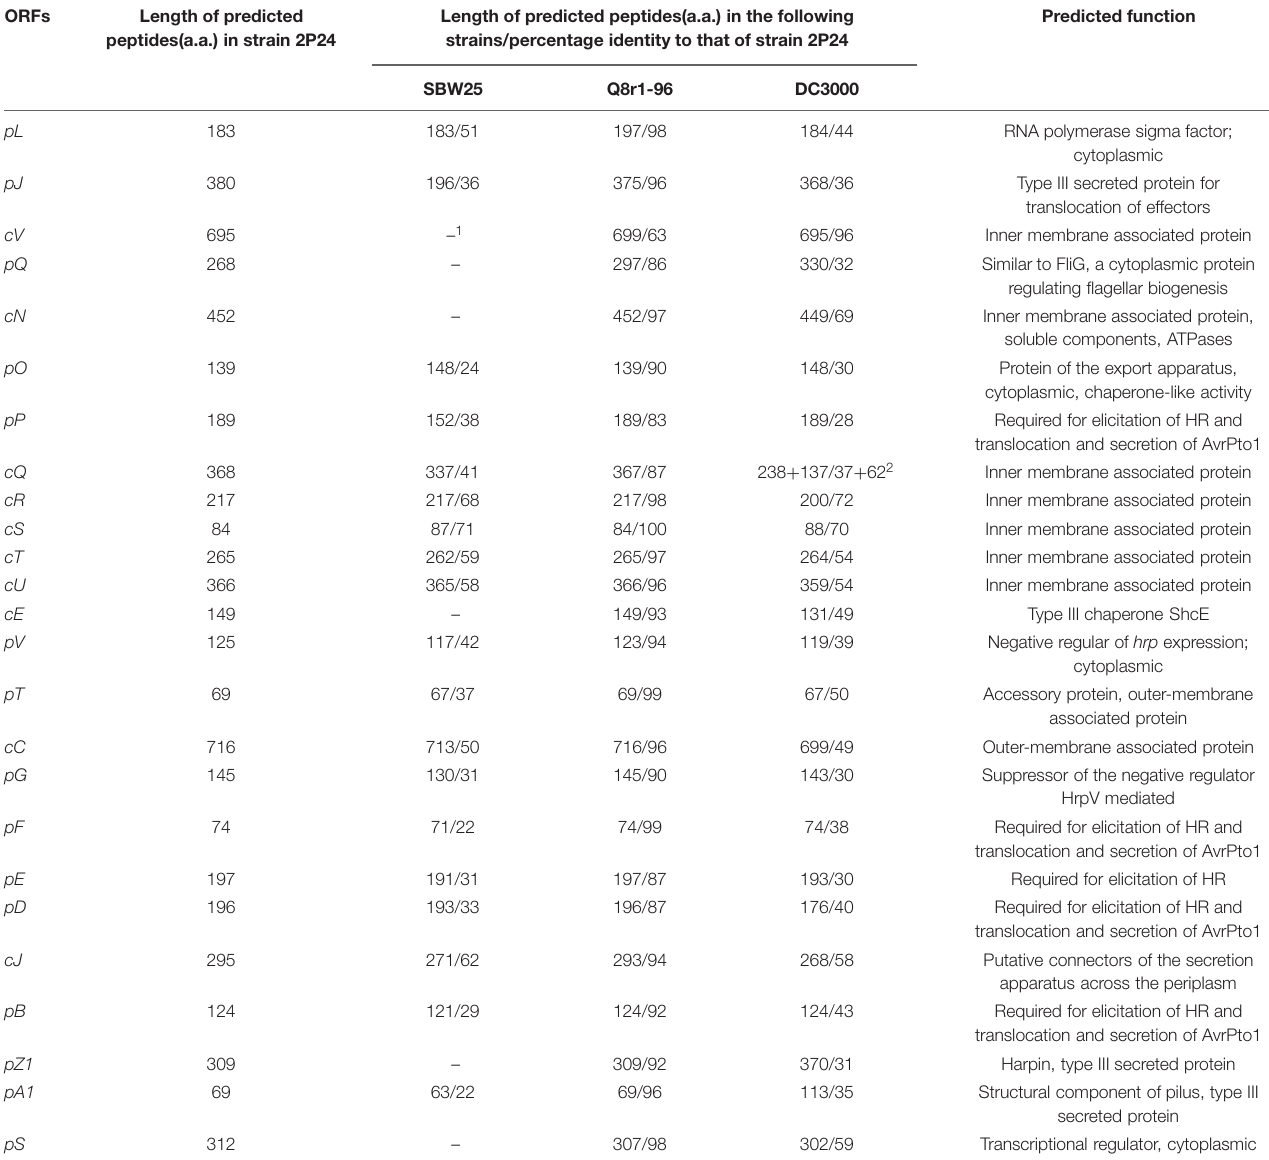
TABLE 2 | Comparison of rsp/rsc and hrp/hrc cluster proteins in P. fluorescens and P. syringae.